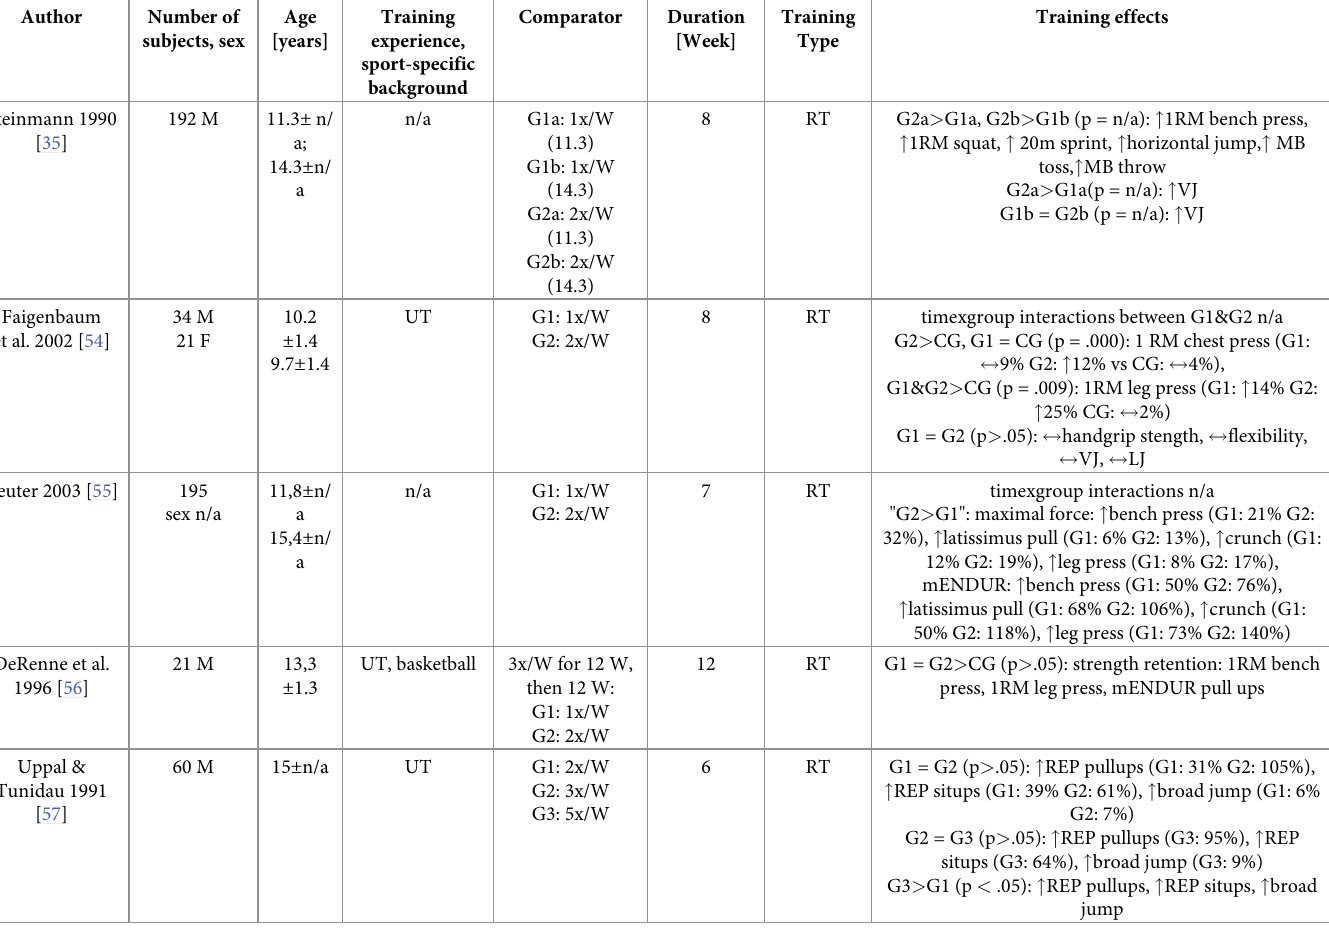
Table 4. Influence of the moderating variable ‘training frequency’ on resistance training induced improvements in components of physical